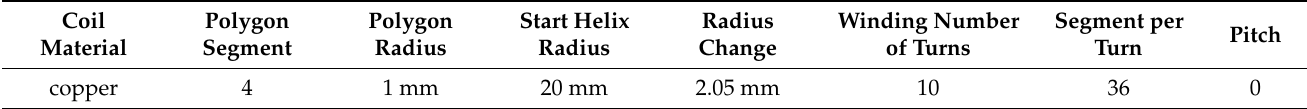
Table 1. Default parameters for the model.